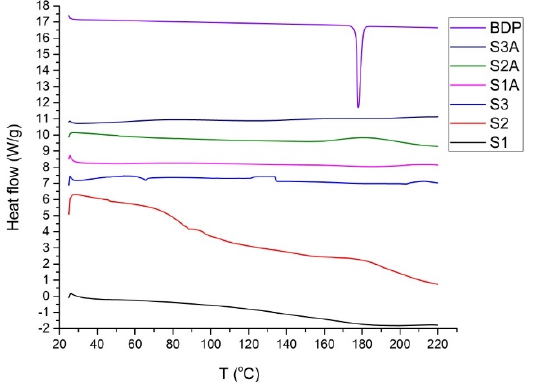
Figure 1. DSC scans of pure BDP and films generated from both drug-loaded and unloaded sam-